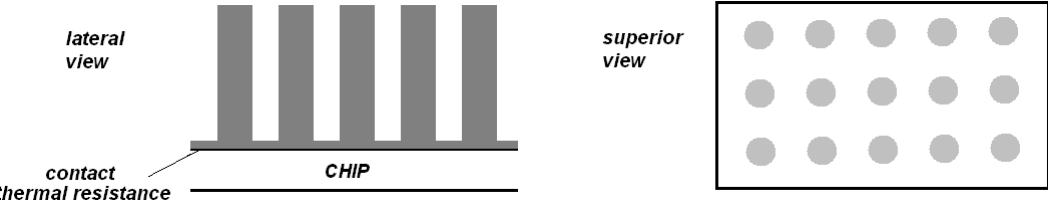
Figure 1. Set of cylindrical fins placed on a chip with the aid of a thermal paste (which gives rise to a thermal contact resistance).